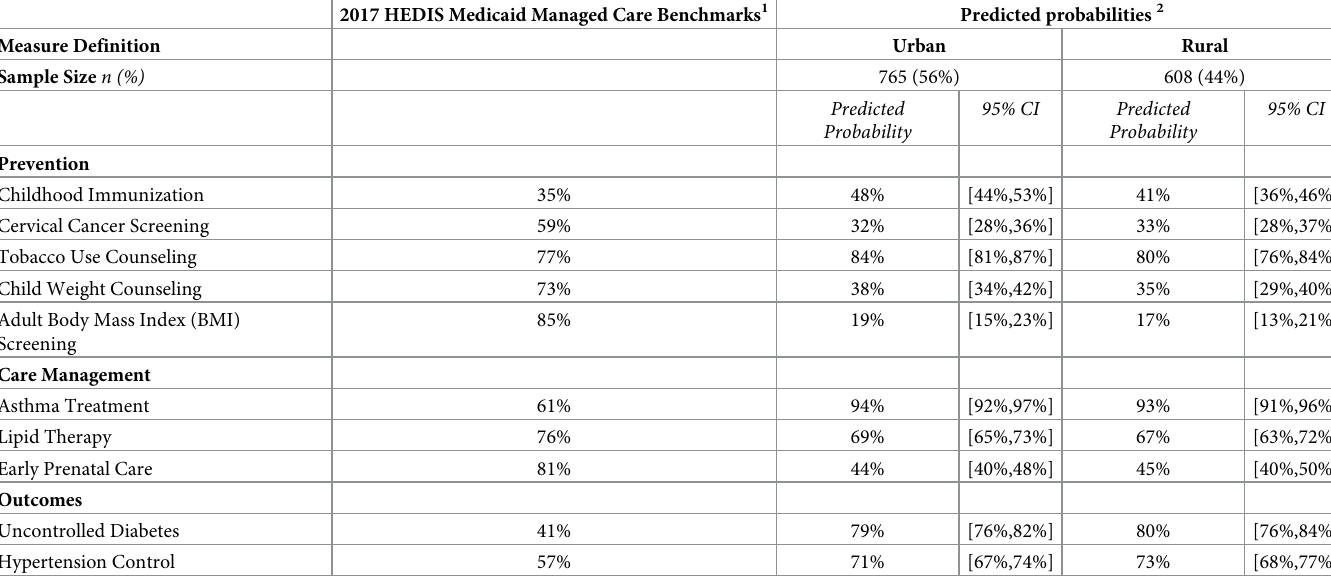
Table 2. Predicted probabilities of proportion of urban and rural health centers that met or exceed quality